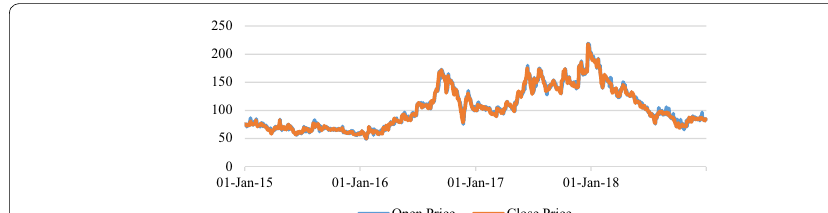
Fig. 2 Bombay stock exchange dataset overview